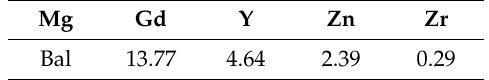
Table 1. Chemical composition (wt %) of Mg-13Gd-4Y-2Zn-0.5Zr alloy.